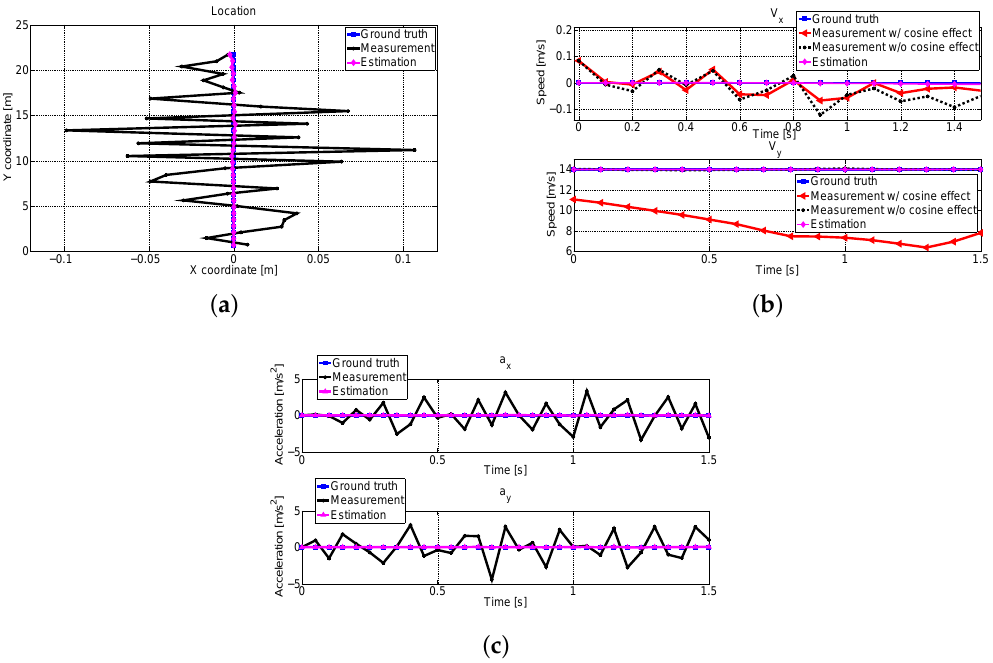
Figure 15. V2’s combined measurement and estimated trajectory results about V1: ( a ) Position comparison. ( b ) Measured and estimated velocities with respect to x and y axes with and without compensation. ( c ) Calculated acceleration